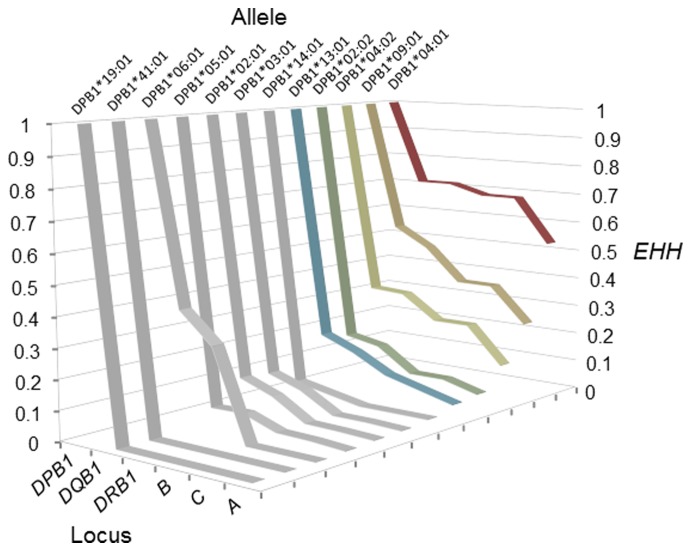
Extended HH (EHH) × relative locus position for12 HLA-DPB1 alleles.